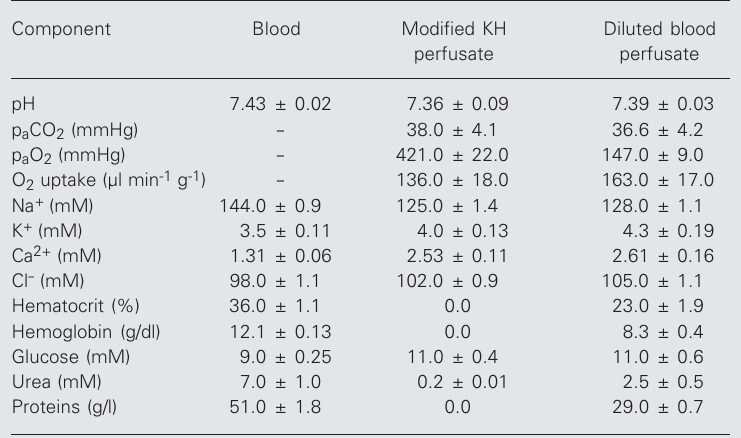
Table 1. Composition of slaughterhouse mixed blood, modified Krebs-Henseleit (KH) perfusate and diluted blood perfusate.